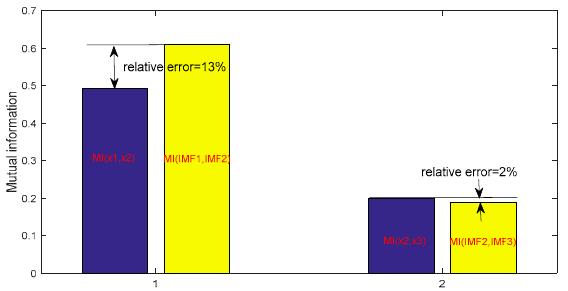
Figure 5. Mutual information (MI) comparison of information component of original signal and corresponding intrinsic mode functions (IMFs).